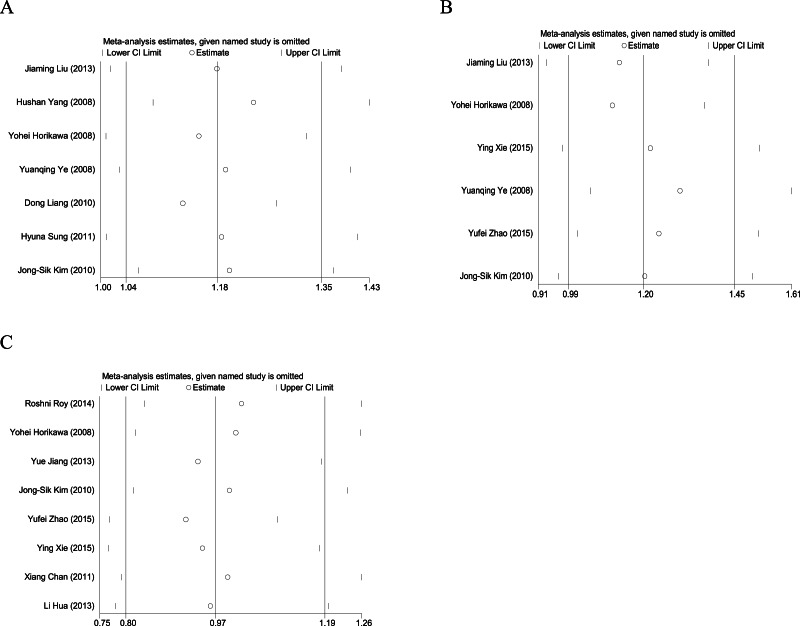
Sensitivity analysis of Gemin4 rs7813 (A), rs2740348 (B) and Gemin3 rs197412 (C).